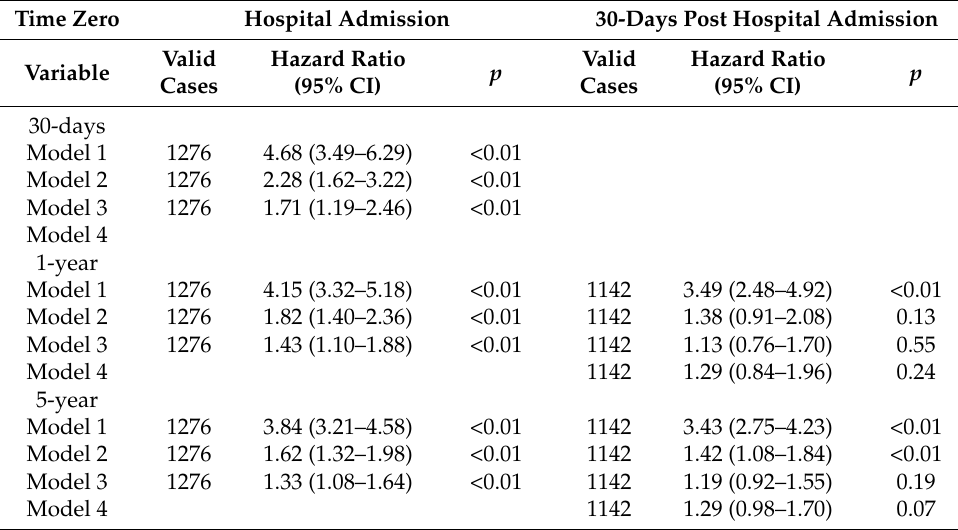
Table 4. All-cause mortality in non-CD patients versus CD